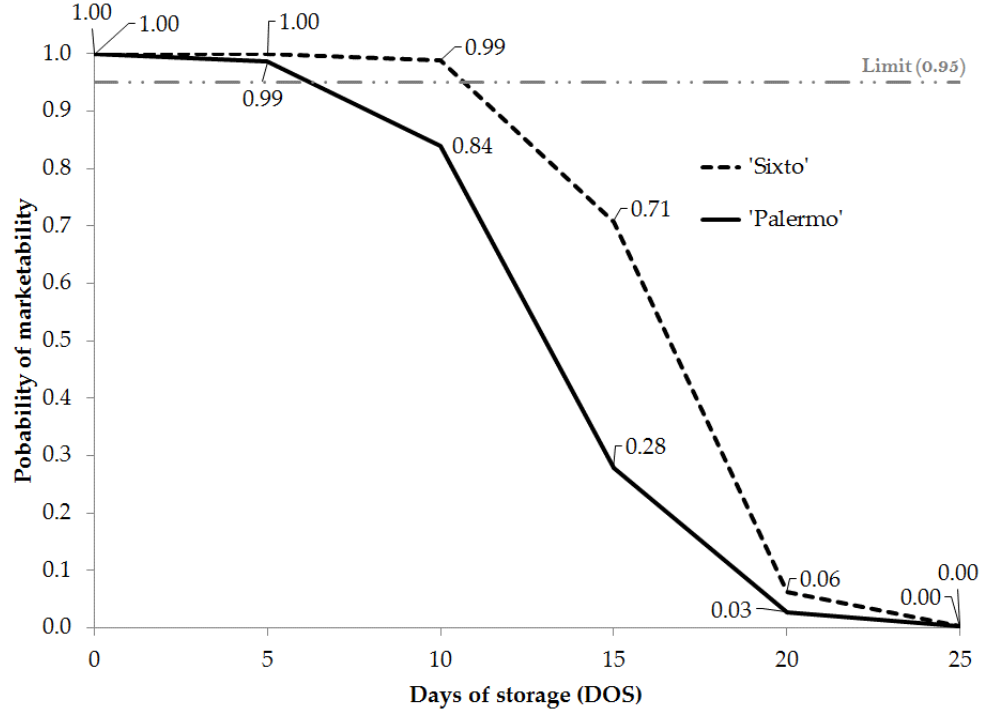
Figure 5. Time evolution of the probability of marketability for the ‘Palermo’ and ‘Sixto’ red pepper cultivars. The results come from the simple independent logistic model for each cultivar, as a function of the number of days of storage (DOS).